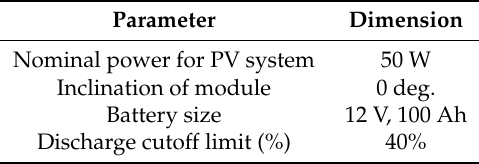
Table 5. Parameter settings for energy estimation from solar PV panels (CT50 Solar Marine). Parameter